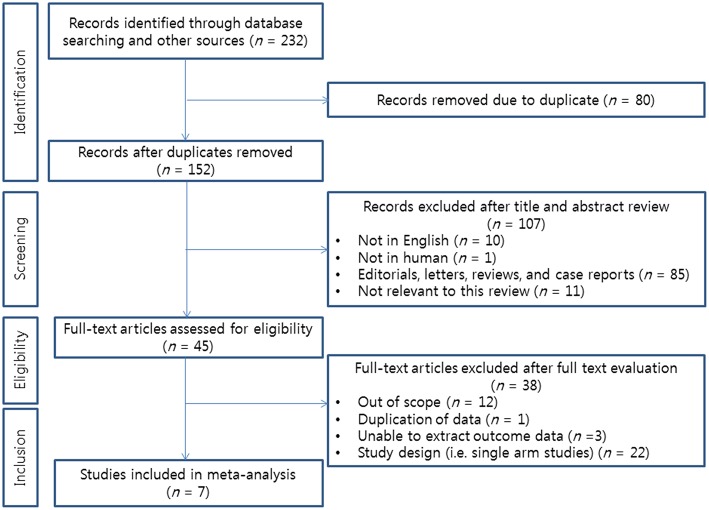
PRISMA flow diagram describing the search strategy used for network meta-analysis.